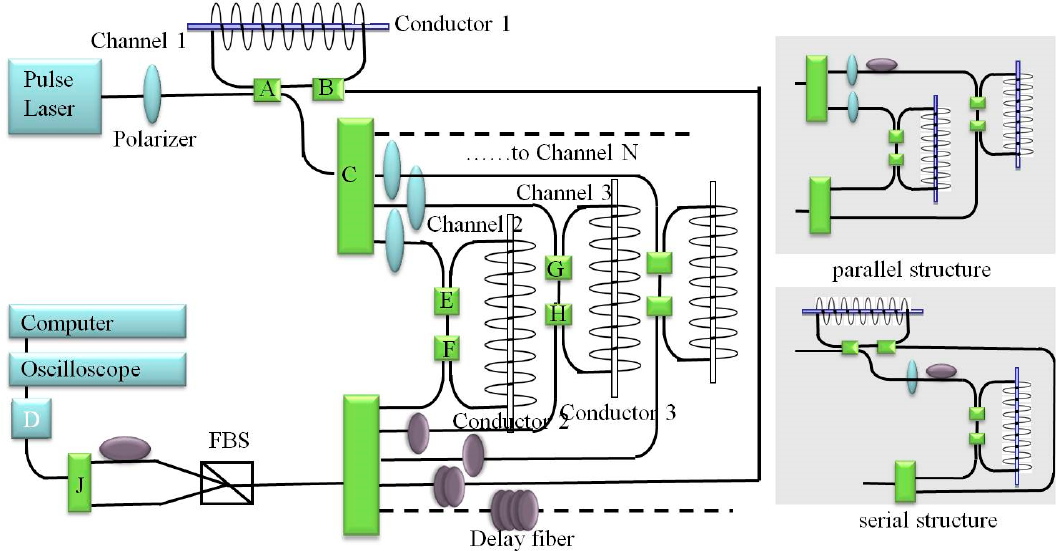
Figure 1. Configuration of the hybrid-structure multichannel all-fiber current sensor.